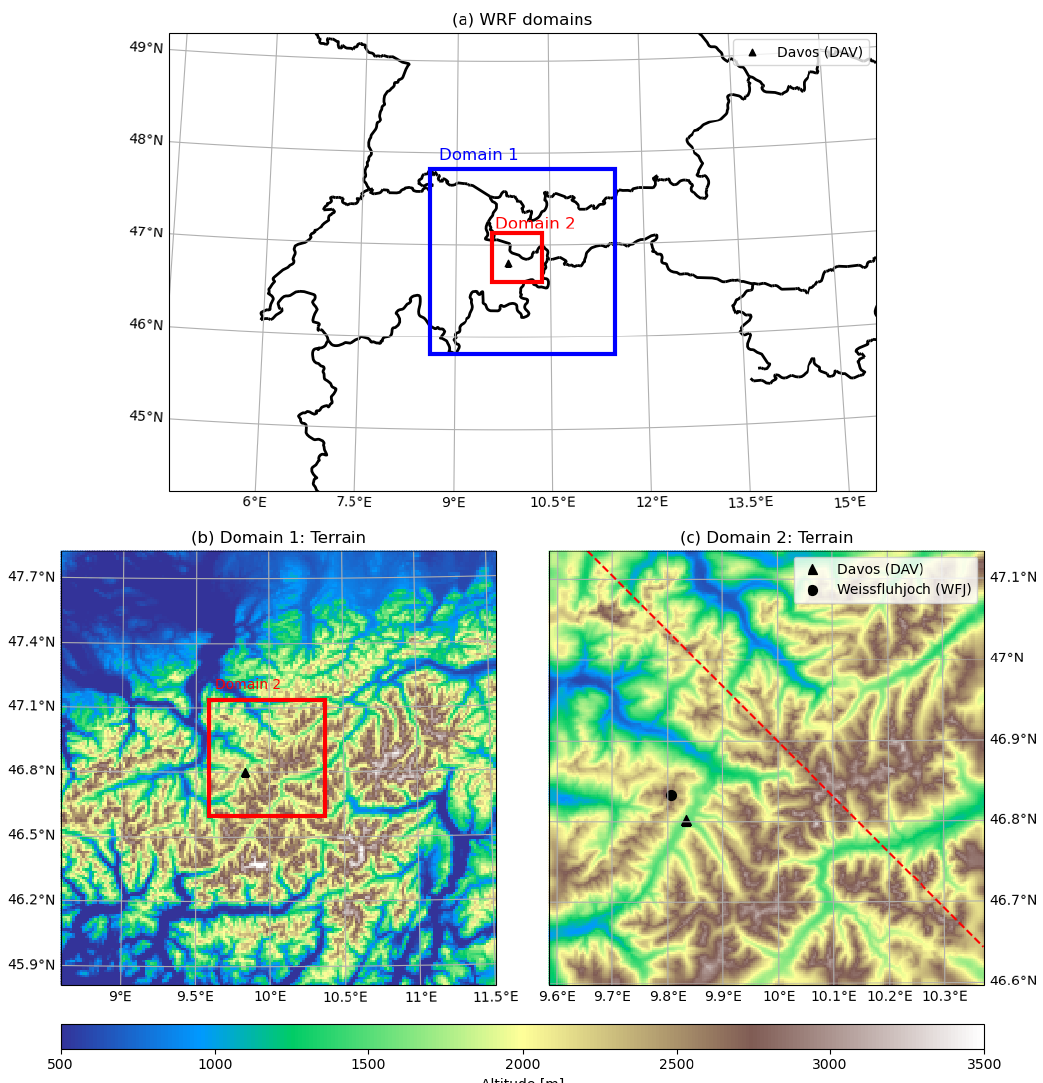
Figure 13. Location of the nested simulation domains for case study II. (a) Extent of the WRF domains with the location of Davos (DAV) shown (black triangle). (b, c) Underlying topography of the two domains, respectively. The red dashed line across the domain in panel (c) is the location of the along-wind cross-sectional view in Fig. 17 and Video M2 in the